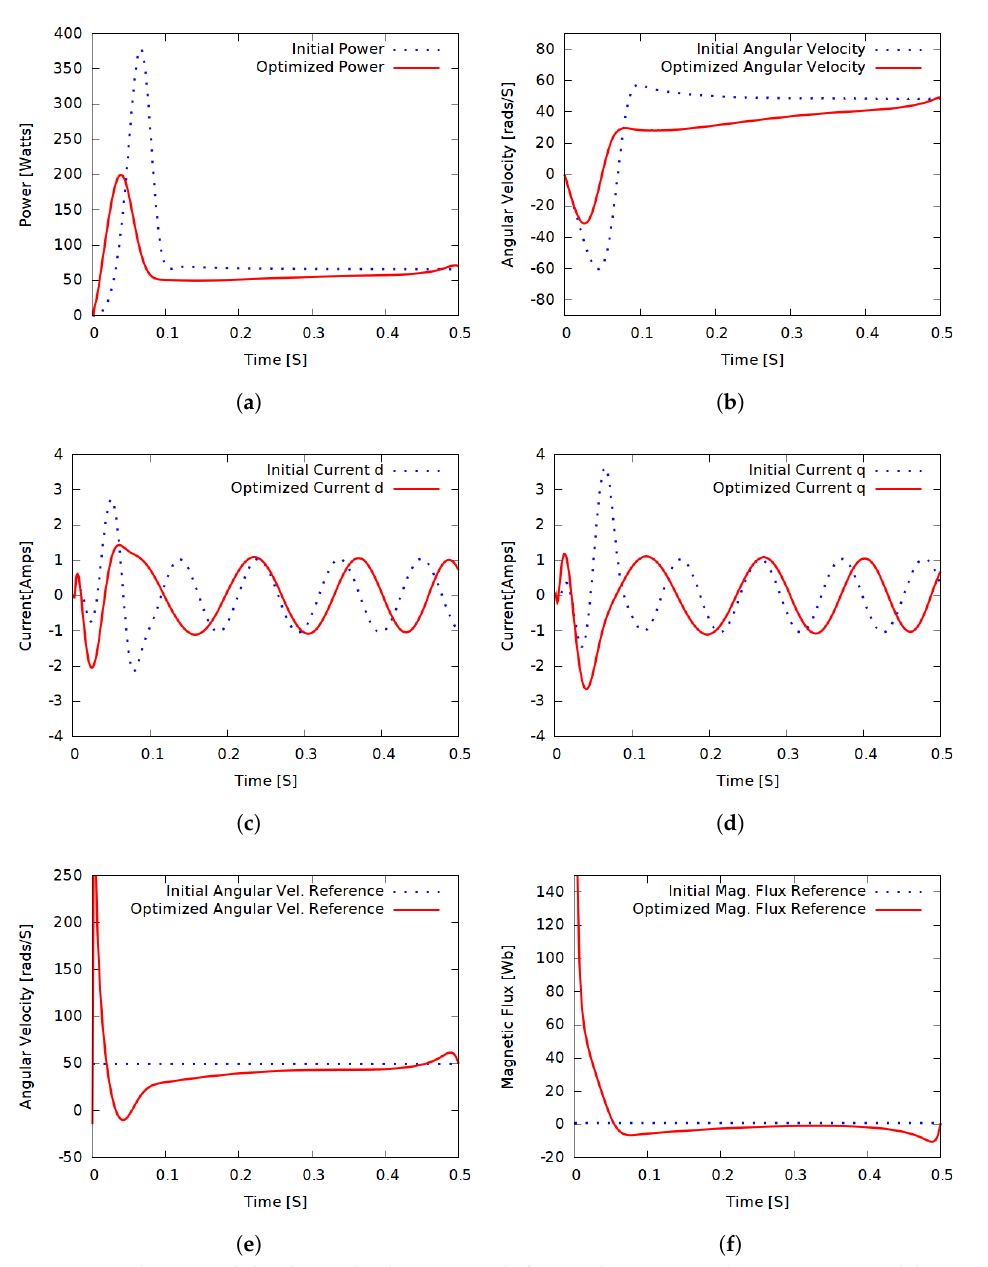
Figure 4. Simulation with load. Final velocity 50 rads/s. Final time: 0.5 s. ( a ) motor power; ( b ) motor angular velocity; ( c ) motor supply current d -axis; ( d ) motor supply current q -axis; ( e ) angular velocity reference; ( f ) magnetic flux